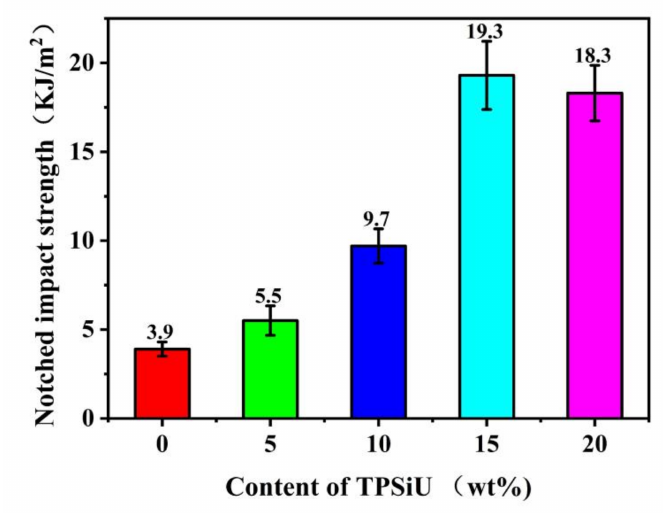
Figure 11. Effects of TPSiU content on the notched impact strength of PLA/TPSiU blends.